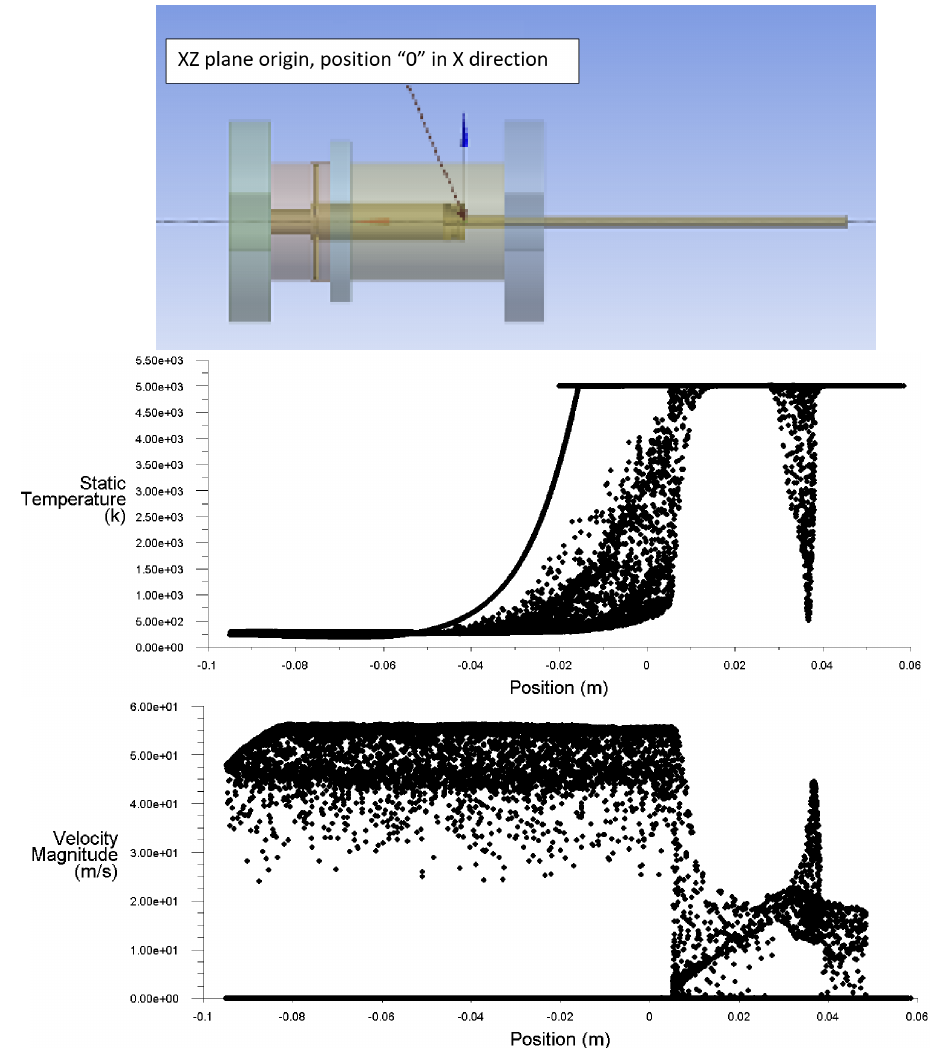
Figure 13. Velocity–temperature profile vs.